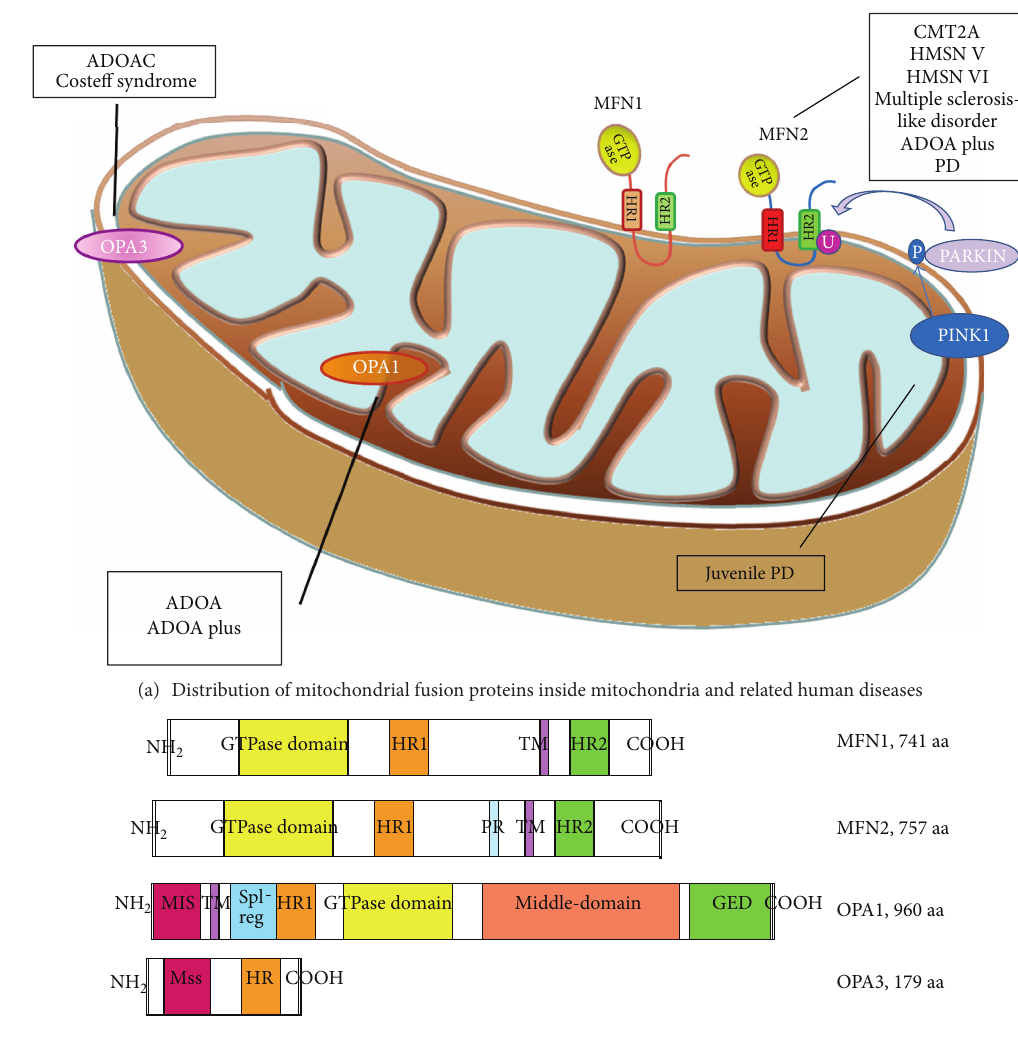
Figure 1: Distribution of mitochondrial fusion proteins inside mitochondria and related human diseases resulting from defects in gene expression or protein function (a). Mitofusin 2 (MFN2) and optic atrophy protein 3 (OPA3) are present in the outer mitochondrial membrane; dynamin-relatedproteinopticatrophy1(OPA1)islocalizedintheintermembranespaceandistetheredtotheinnermitochondrialmembrane. The top right of the figure illustrates the molecular pathway responsible for mitophagy: PTEN-induced putative kinase protein 1 (PINK1) phosphorylates Parkin, an ubiquitin E3 ligase that targets several outer membrane proteins including mitofusin. Ubiquitination of MFN2 in damaged mitochondria starts the mitophagic process. ADOA: autosomal dominant optic atrophy; ADOAC: autosomal dominant optic atrophy and cataract; HR: heptad repeat; PD: Parkinson’s disease. Below (b), schematics of functional domains of the mitochondrial fusion proteins (HR: heptad repeat domain; TM: transmembrane domain; PR: proline-rich domain; MIS: mitochondrial import sequence; GED: GTPase effector domain; Mss: mitochondrial signal